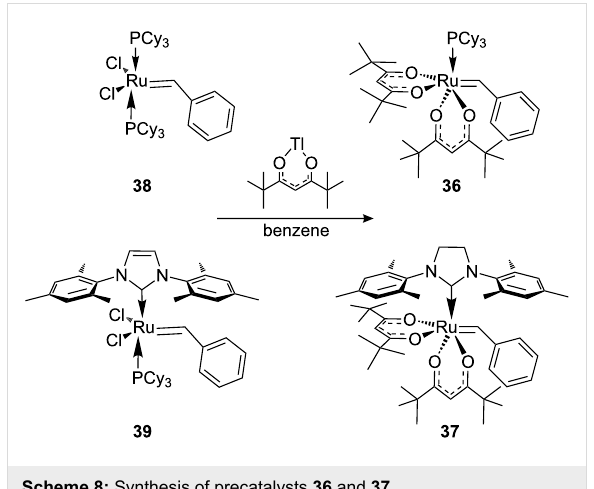
Scheme 8: Synthesis of precatalysts 36 and 37 .